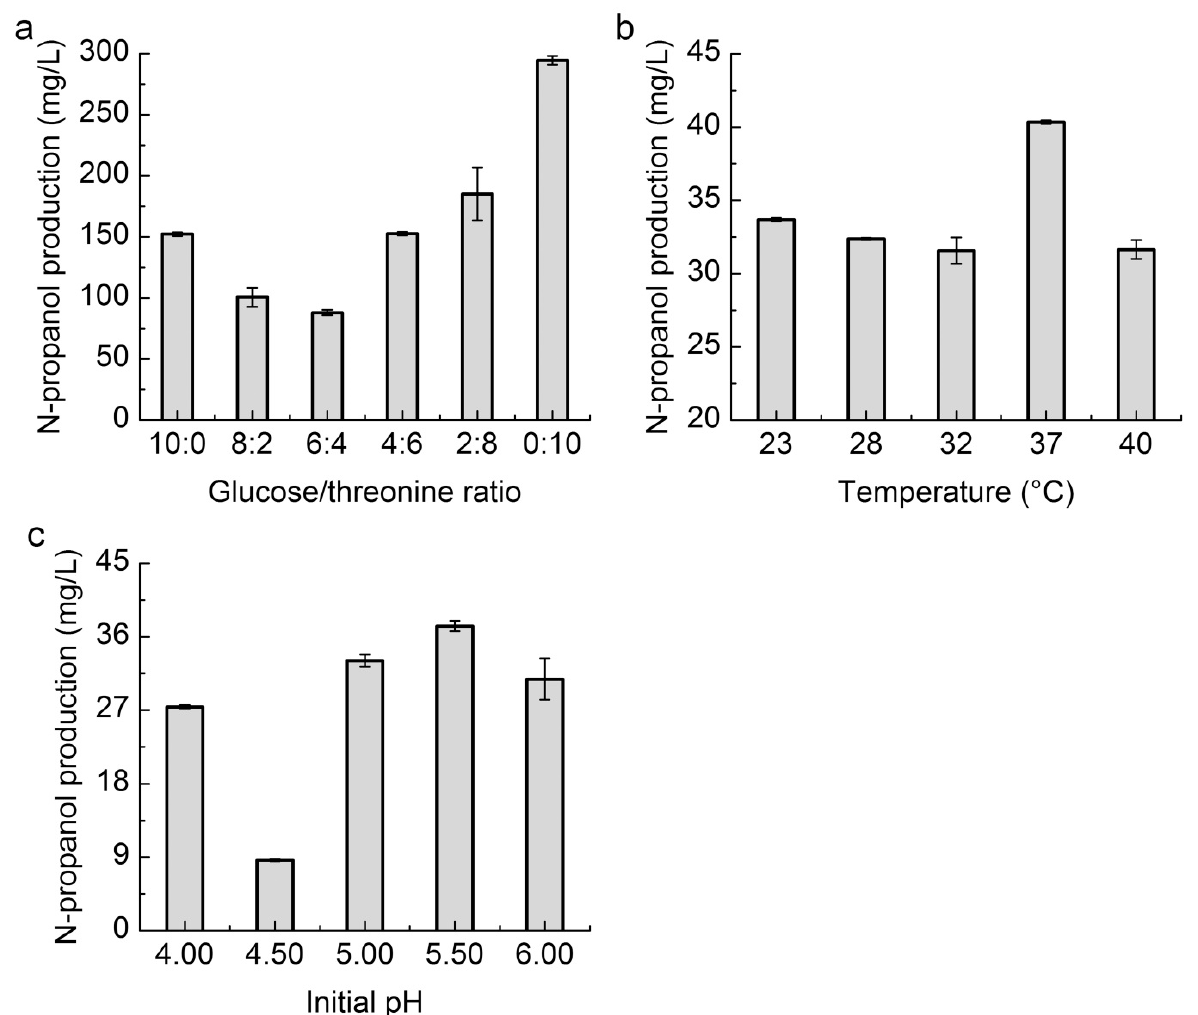
Figure 2. Effects of several factors on n-propanol production. ( a ), ratio of additional glucose to threonine; ( b ), temperature; ( c ), initial pH. Each parameter was tested at least in triplicate. Error bars represent the standard deviation of the mean. The optimum conditions were ( a ) 6:4; ( b ) 32 °C; and ( c ) pH4.50.